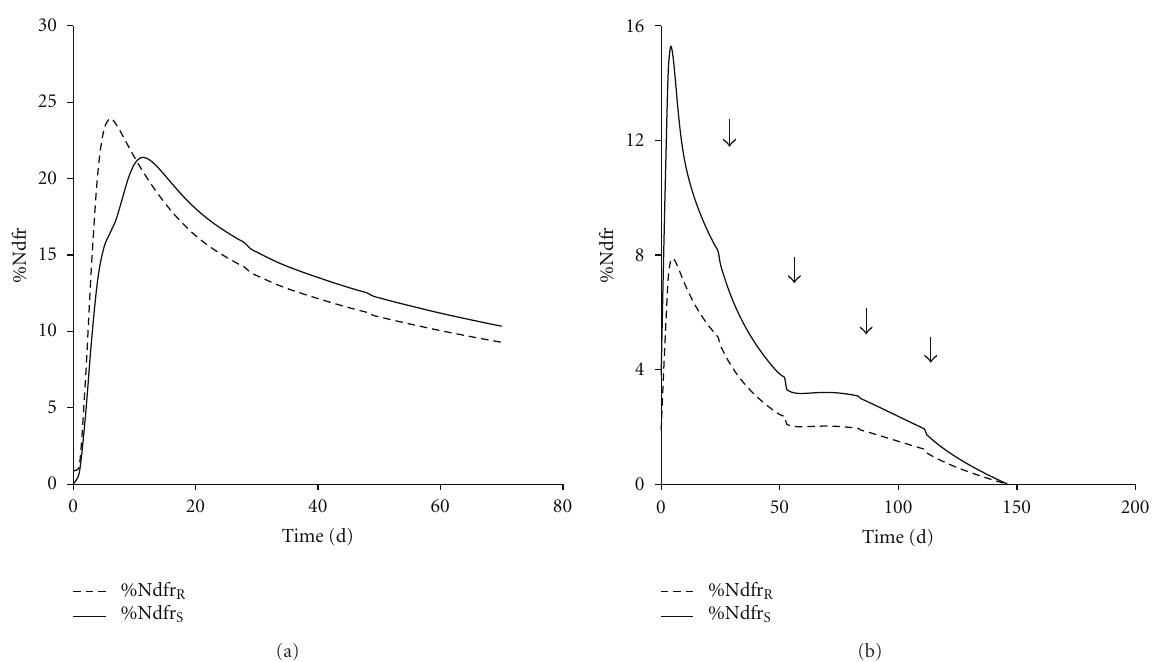
Figure 4: E ff ect of δ 15 N of residue on N uptake estimates (proportion of plant N derived from residue) in (a) the residue application experiment (RA), and (b) the full interaction experiment (FI). %Ndfr R : calculated with total initial δ 15 N of residue, and %Ndfr S : calculated with simulated δ 15 N of N released from residue (%Ndfr S ). Arrows indicate shoot harvesting in the FI experiment.